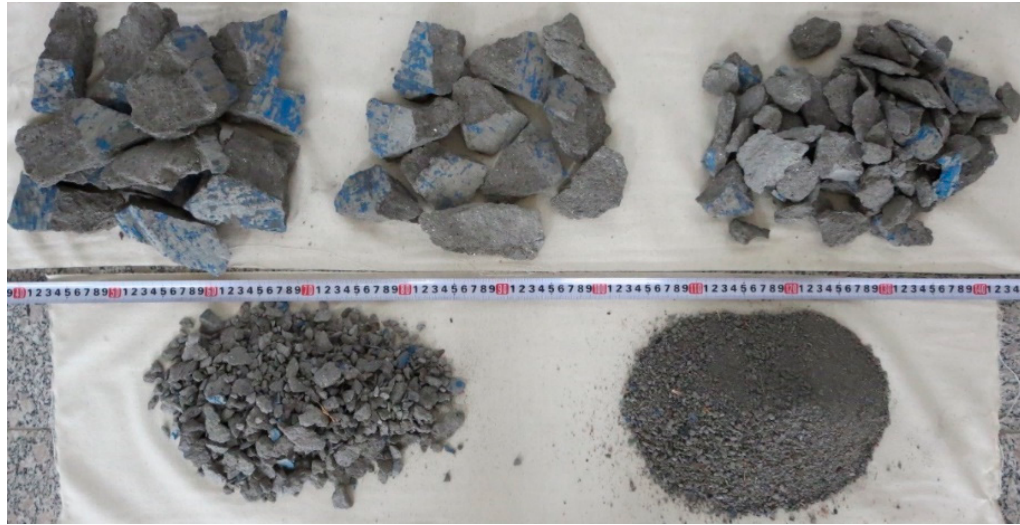
Figure 9. Collected concrete fragments after test #9 (piled by more than 100 g, 50~100 g, 10~50 g, 0.2~10 g, less than 0.2 g). Appl. Sci. 2020 , 9 , x FOR PEER REVIEW